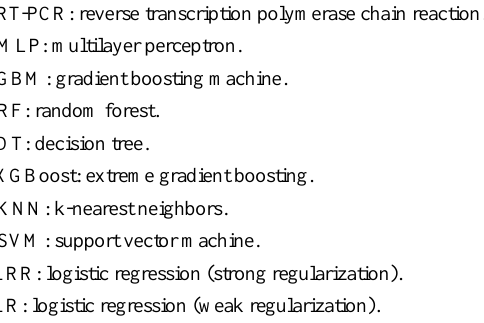
Table 2. Results of 10-fold cross-validation for the classification models using the unbalanced and balanced data sets. RT-PCR a unbalanced and